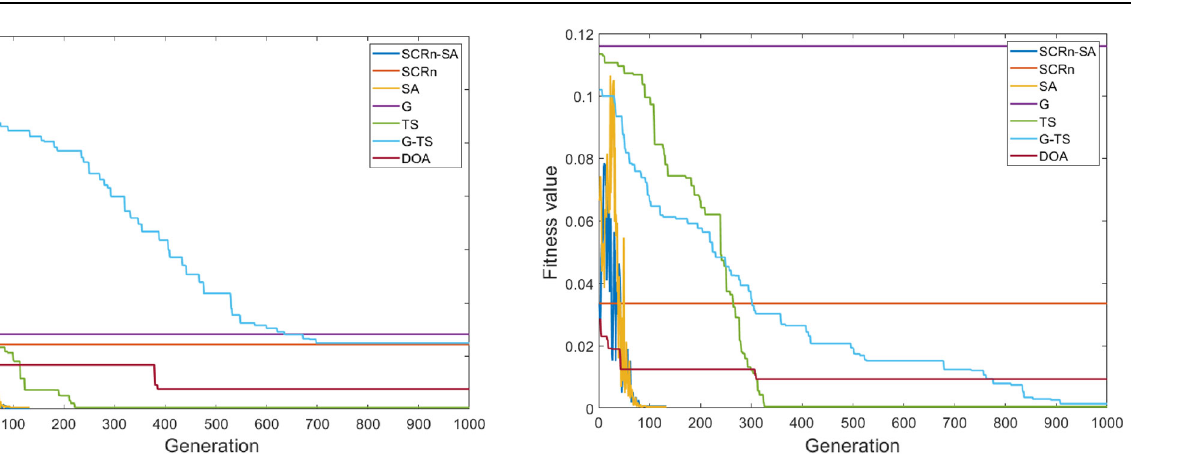
Fig. 5 Convergence curve for f